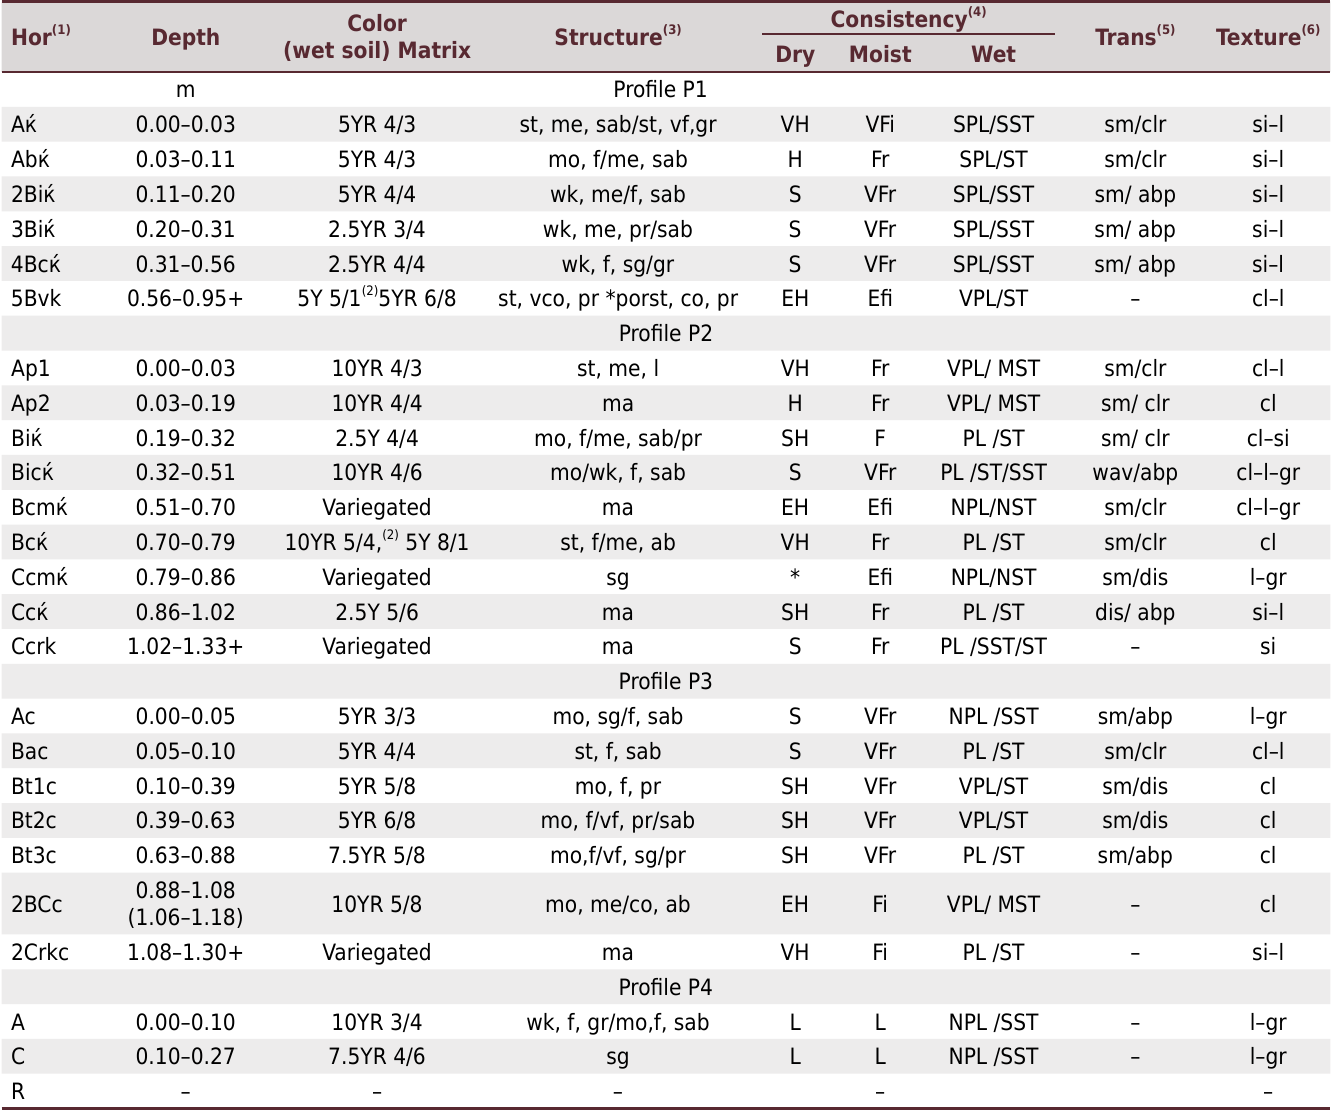
Table 1. Morphological properties of soils from the Apodi